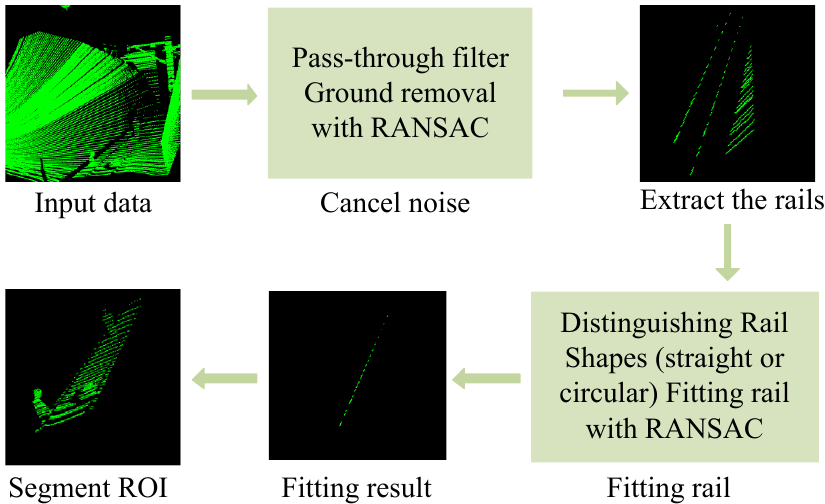
Figure 2. Procedure for drawing boundaries around tracks.